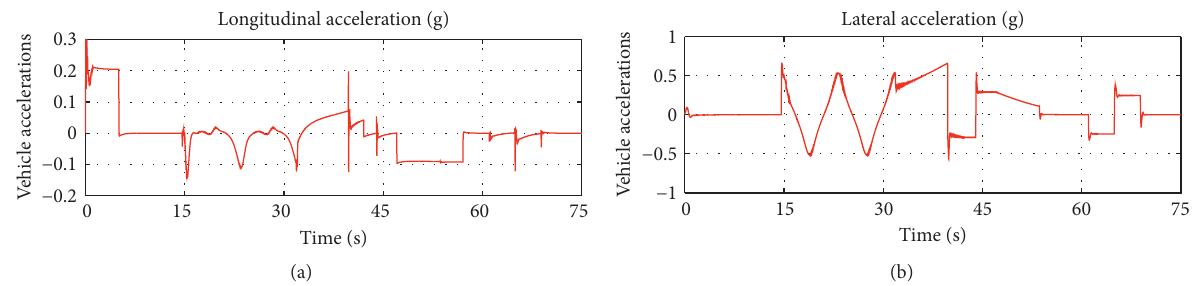
Figure 23: Time histories for longitudinal and lateral accelerations of the path-following